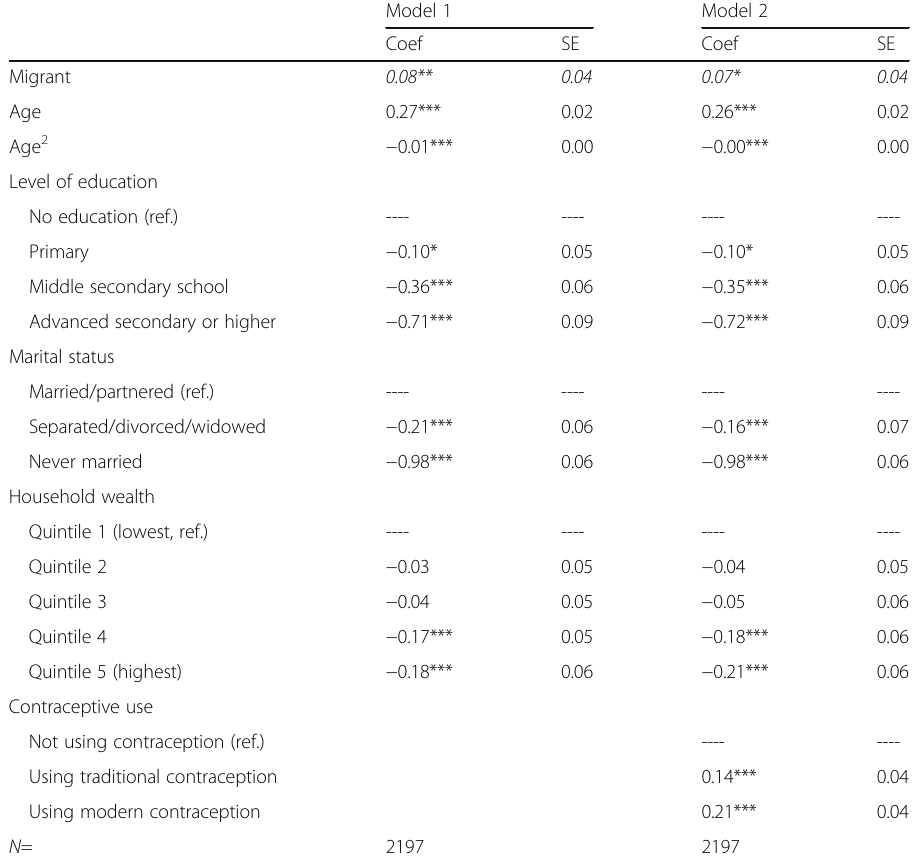
Table 3 Poisson regression results for differences in lifetime fertility between migrants and non- migrants, PMA2020 Project, Kinshasa